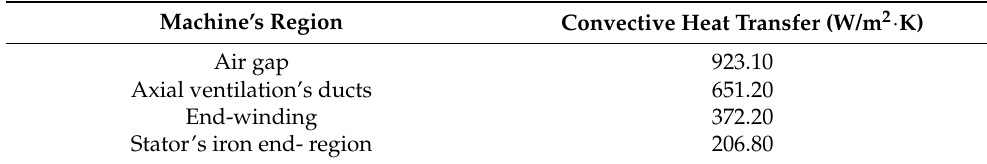
Table 6. The estimated coefficient of convective HT.